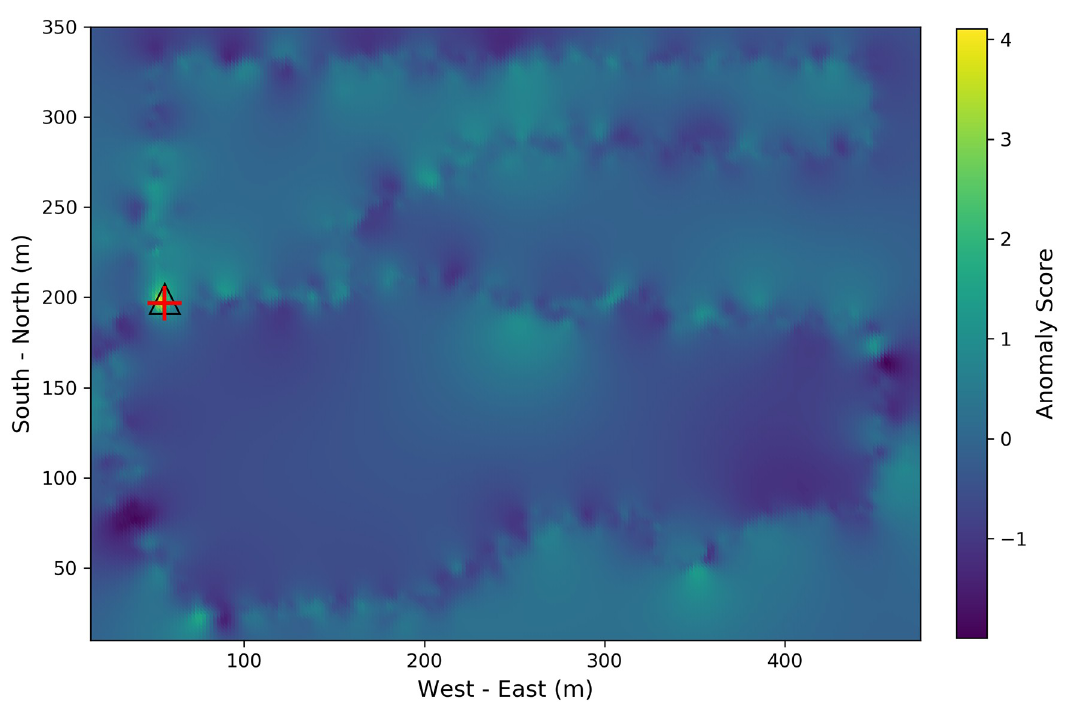
Fig 6. Anomalous source localization from Poisson kriging model. The background color corresponds to the anomaly score calculated using Eq 19. The injected source was denoted by red cross and the estimated source location was denoted by black triangle.